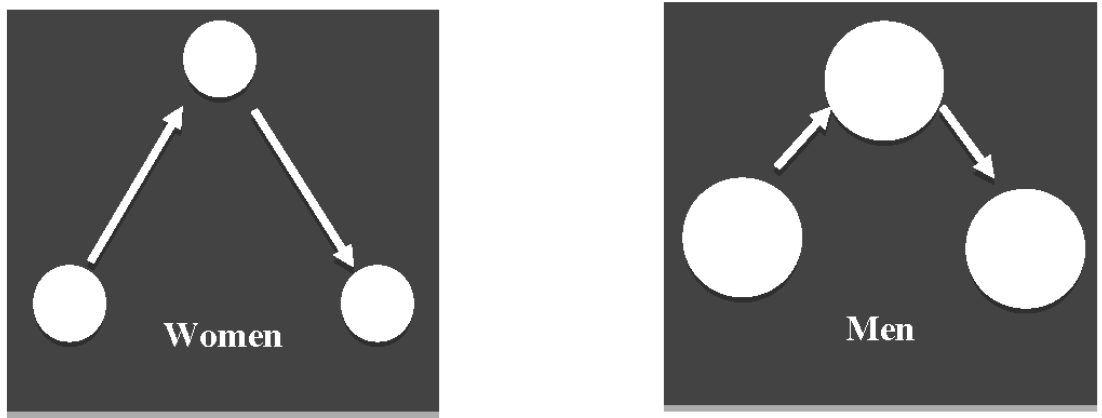
Figure 1. A schematic illustration of gaze during autobiographical retrieval: women demonstrated shorter fixations (i.e., smaller circles) but longer saccades (i.e., longer arrows) compared to men.